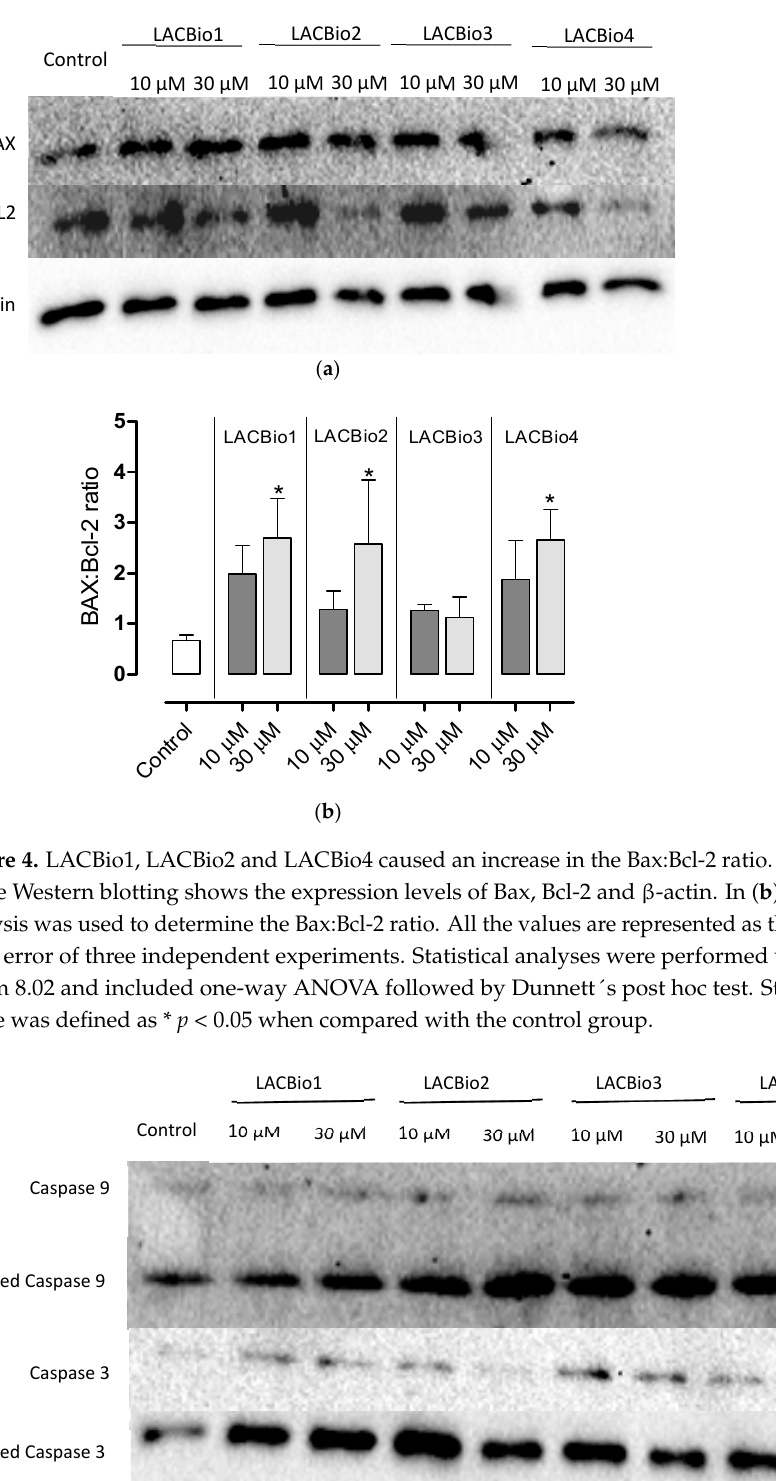
(b) Figure 5. LACBio1, LACBio2, LACBio3 and LACBio4 activate the intrinsic caspase cascade. ( a ) Representative Western blots showing levels of expression of caspase 9, caspase 3 and β -actin. ( b )